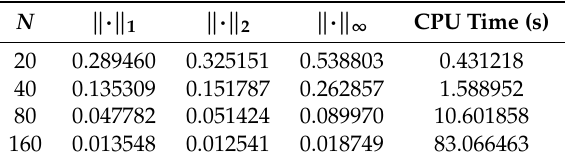
Table 4. Error table using WENO-FDM for the approximate solution p ( v , t ) graphically represented in Figure 3, at a final time t = 0.0408 with the finest grid being N ∗ = 320. N